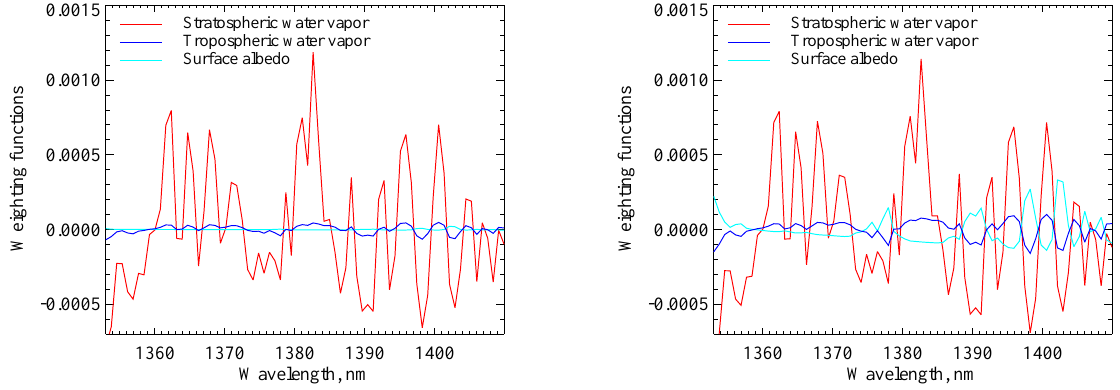
Fig. 6. Weighting functions for the stratospheric water vapor (red), tropospheric water vapor (blue), and surface albedo (cyan) for a typical SCIAMACHY limb observation (left panel) and for a surface elevation of 2km (right